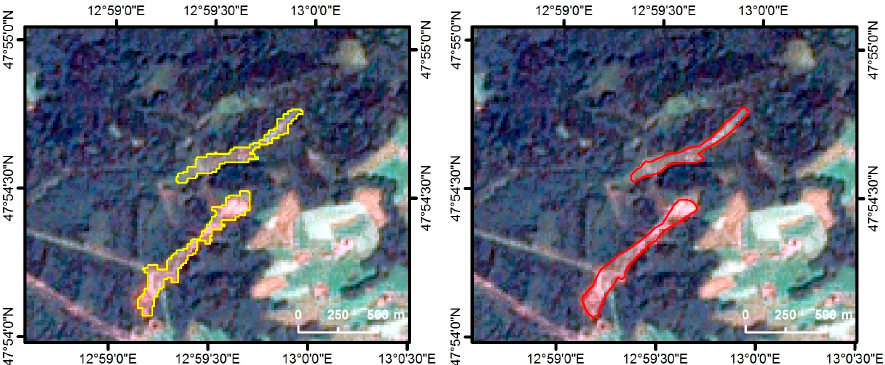
Figure 2. Semi-automatically mapped landslides using the object-based image analysis (OBIA) approach (in yellow; left ) and manually mapped landslides (in red; right ) for study area I based on the Landsat 7 image.